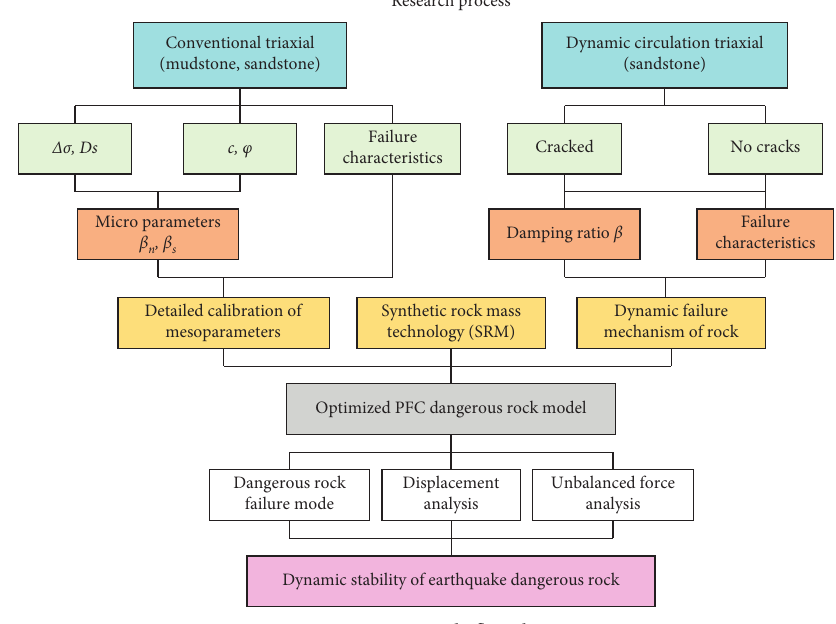
Figure 6: Research